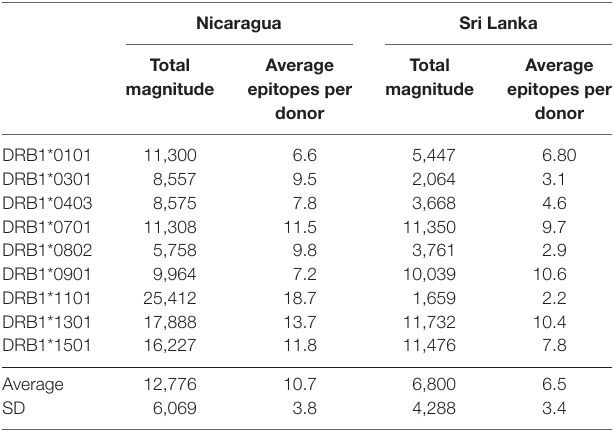
Data from the Sri Lanka donors were published previously (12) and are shown here for reference purpose only.